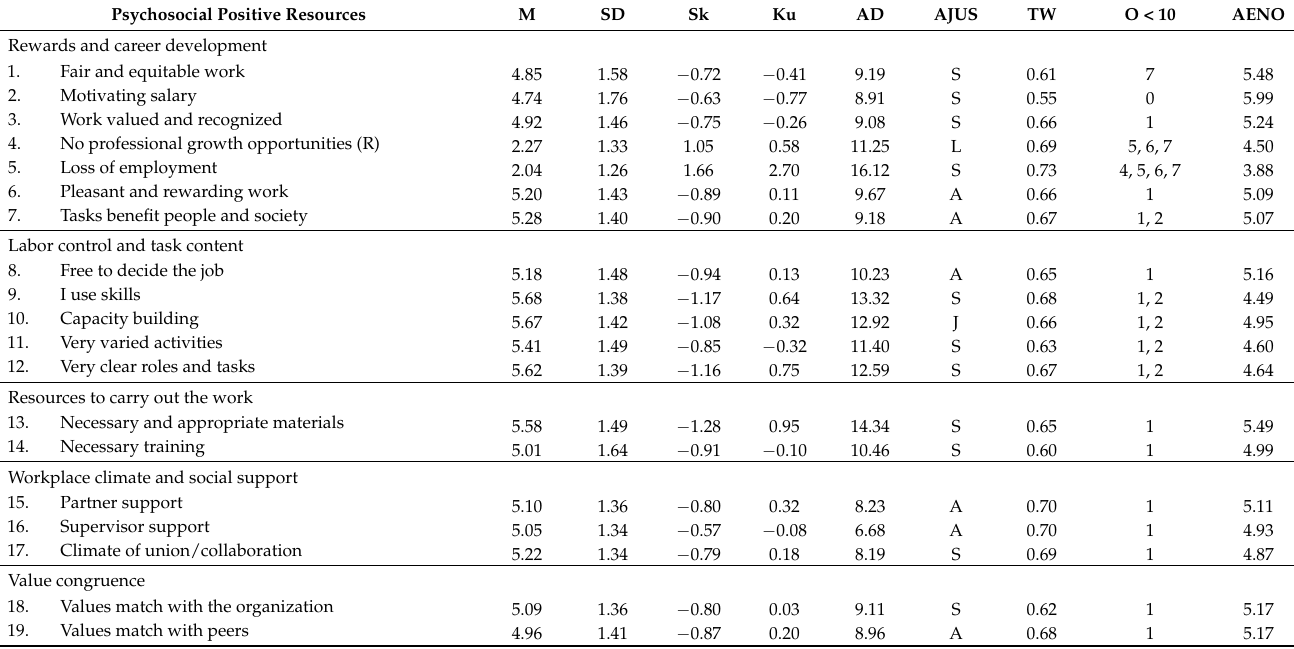
Table 3. Descriptive statistical results of the psychosocial positive resource